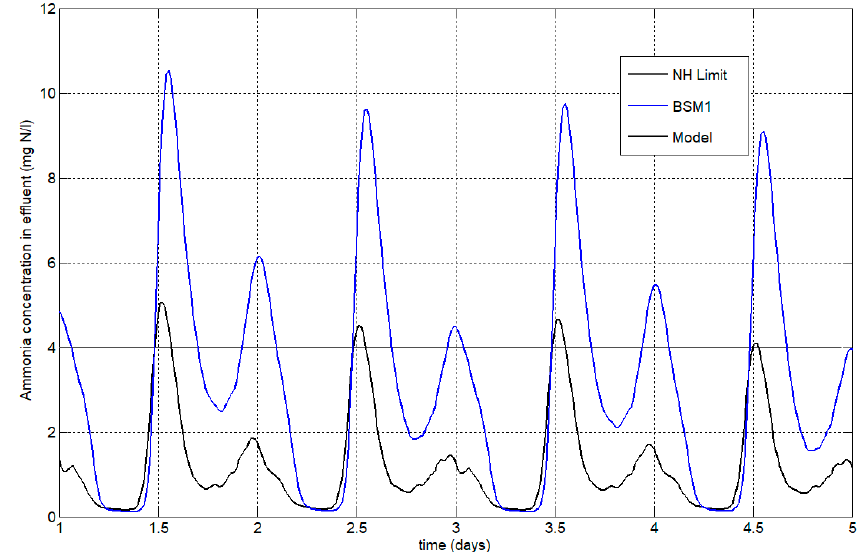
Figure A3. Comparison of the reduced model and BSM1 evolution of the ammonia concentration in the effluent obtained in the open loop operation using the manipulated variables values that produce the nominal set points.